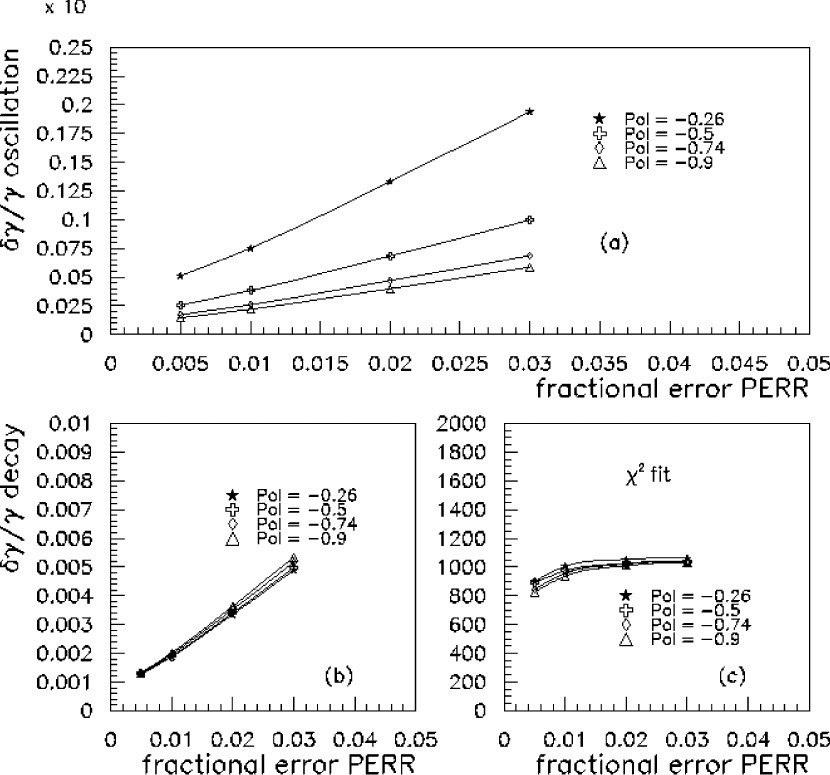
FIG. 59. (a) Fractional error in dg (cid:1) g obtained from the oscillations as a function of polarization ˆ P and the fractional error in the measurements PERR. (b) Fractional error in dg (cid:1) g obtained from the decay term as a function of polarization ˆ P and the fractional error in the measurements PERR. (c) The total x 2 of the fits for 1000 degrees of freedom. PERR is the percentage measurement error on the total electron energy in the calorimeter measuring the decay electrons.